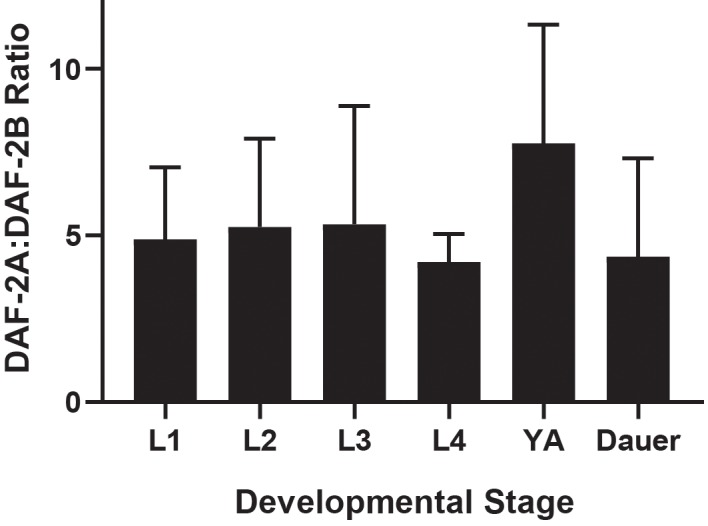
Ratio of daf-2a to daf-2b.Multiplex PCR was performed within the linear range of amplification and band intensities were measured using Image J. Each larval stage was examined in triplicate except dauer (duplicate) and data are presented as mean+ sd.